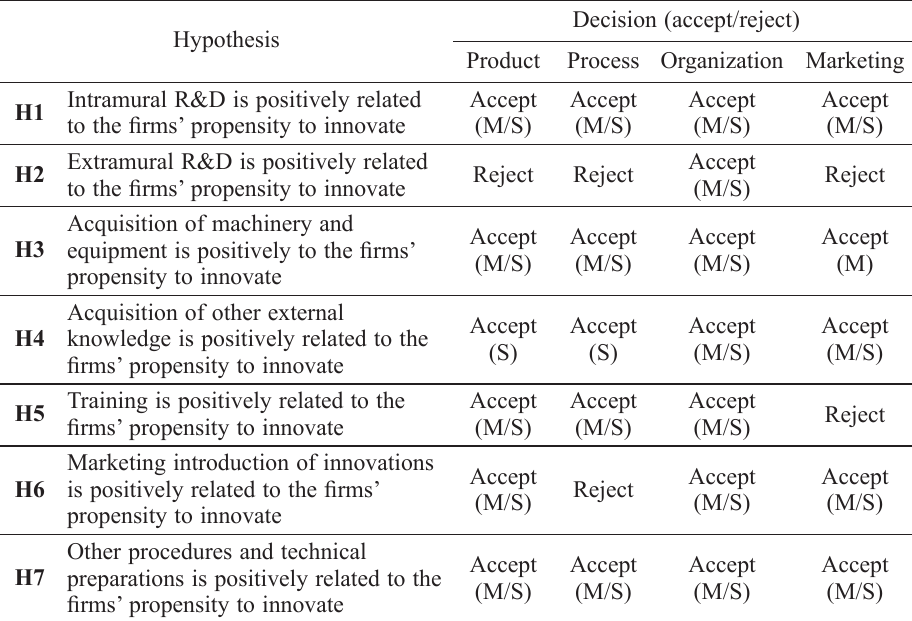
Table 4. Summary of hypothesis